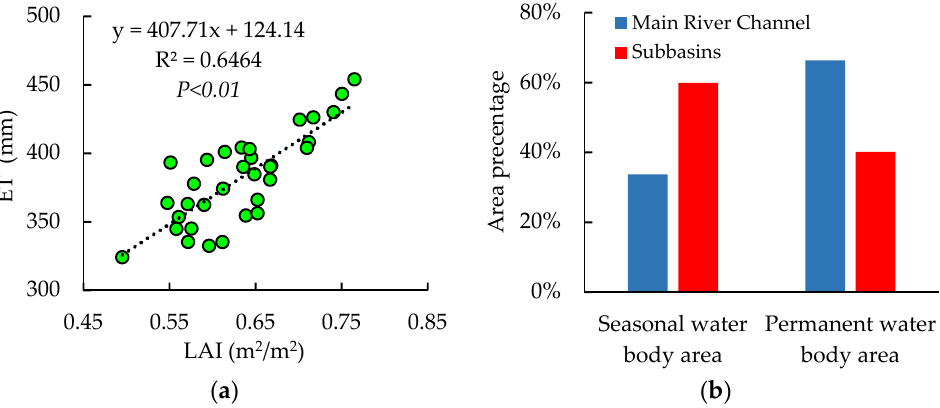
Figure 18. ( a ) Relationship between ET and LAI in the entire YRB, and ( b ) the water body area percentage in the main river channel region and the sub-basins for the permanent and seasonal water